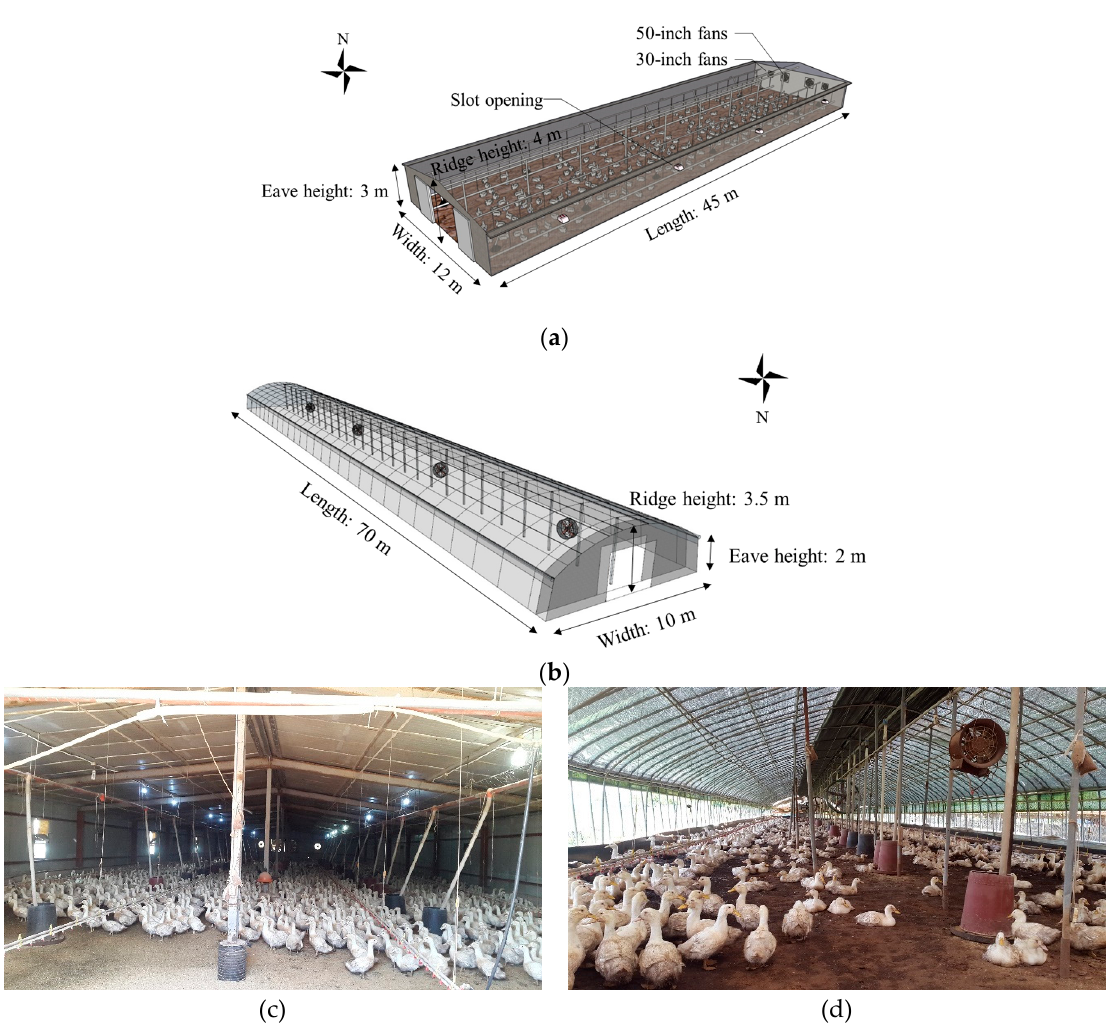
Figure 2. Experimental duck houses located at Sinbuk-myeon, Yeongam-gun, Jeollanam-do Province (126°38 ′ E, 34°53 ′ N). ( a ) Schematic information of mechanically ventilated duck house;